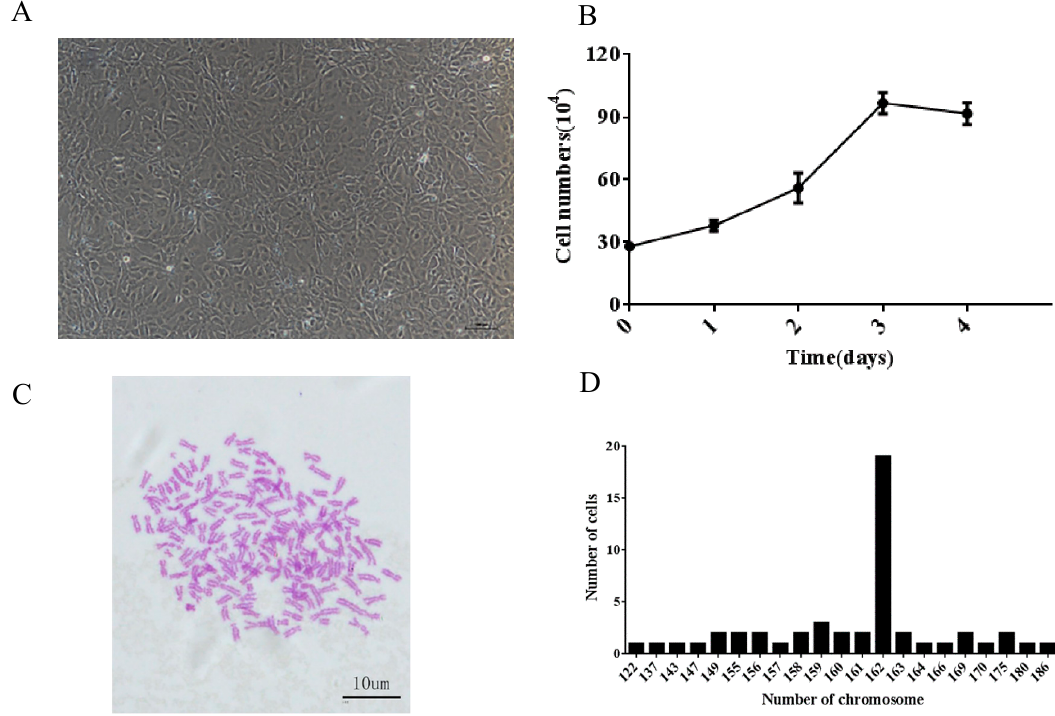
Figure 3. Characteristics of the GCBlat1 cell line: ( A ) Morphology of GCBlat1 cells at passage 80. Scale bars = 100 µm. ( B ) Growth curves of the GCBlat1 cell line at passage 30 at 28 °C within 4 days. Y-axis represents cell numbers of the mean ± standard deviation of three independent experiments. ( C ) Morphological characteristics of chromosomes arrested in metaphase at passage 36. ( D ) Frequency distribution of chromosomes: The x -axis represents the number of chromosomes; the y -axis represents the number of cells analyzed.